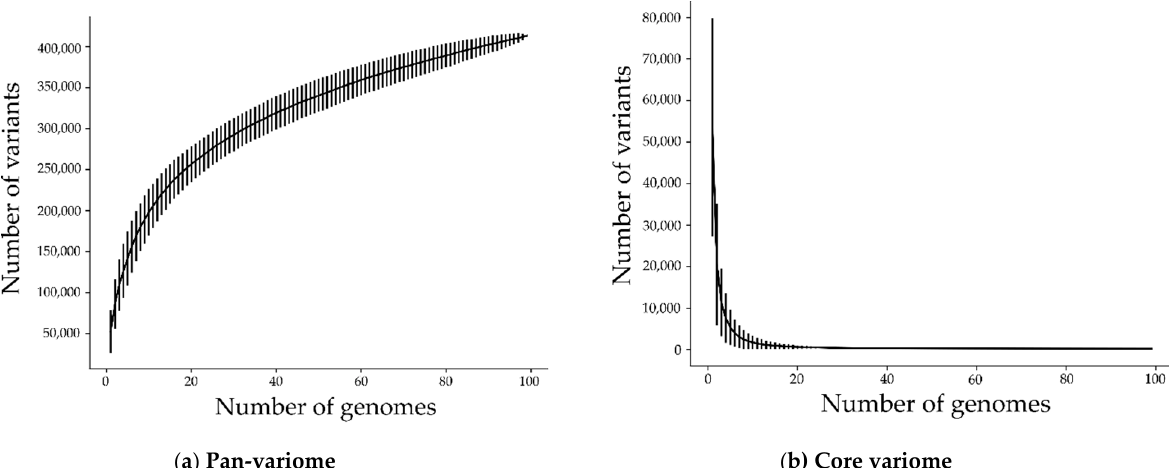
Figure 2. ( a ) Pan-variome (union of variants) and ( b ) core-variome (intersection of variants) of 206,633 high-quality and 206,650 rare variants (413283 in total). The standard deviation is added as error bars around the mean value for 1000 iterations. Most variants appear only in a few of the isolates.